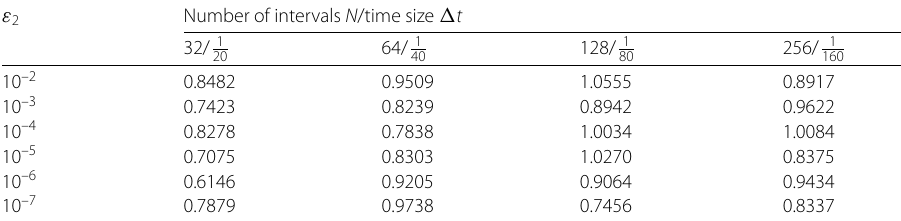
Table 2 Rate of convergence r N , M ε for Example 5.1 using the adaptive grid method with ε 1 = 10 –2 1 , ε 2